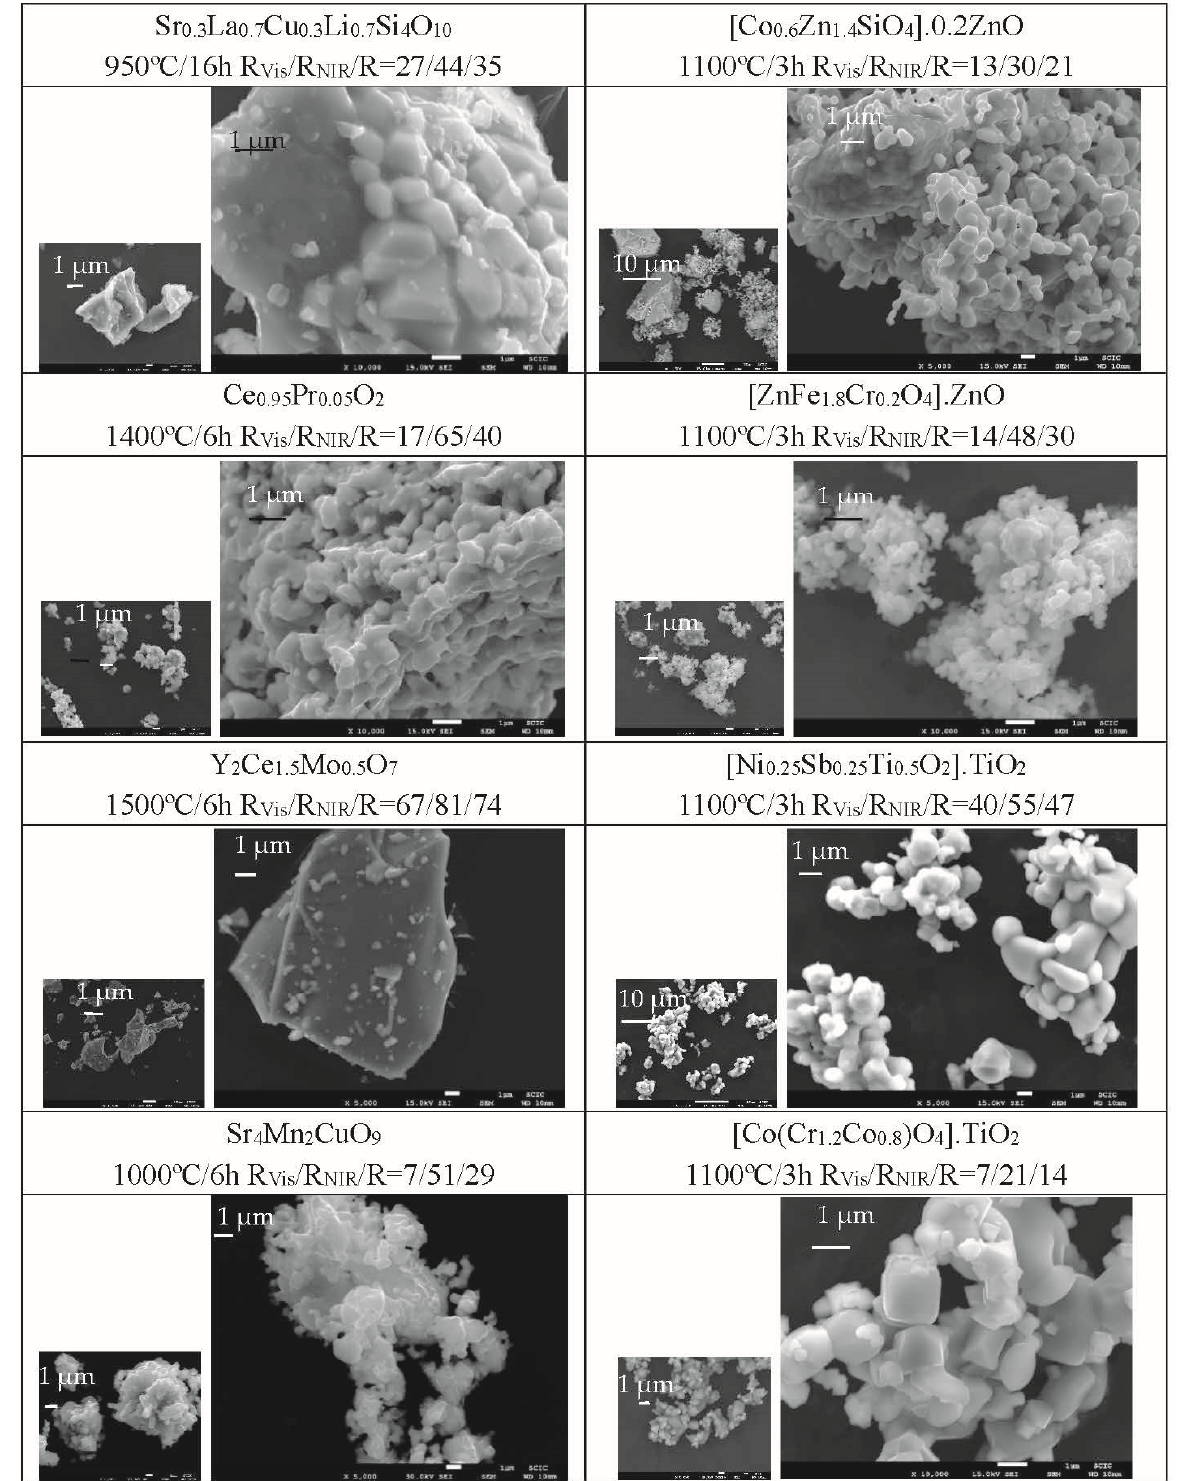
Figure 3. SEM images of powders of the both families of pigments.